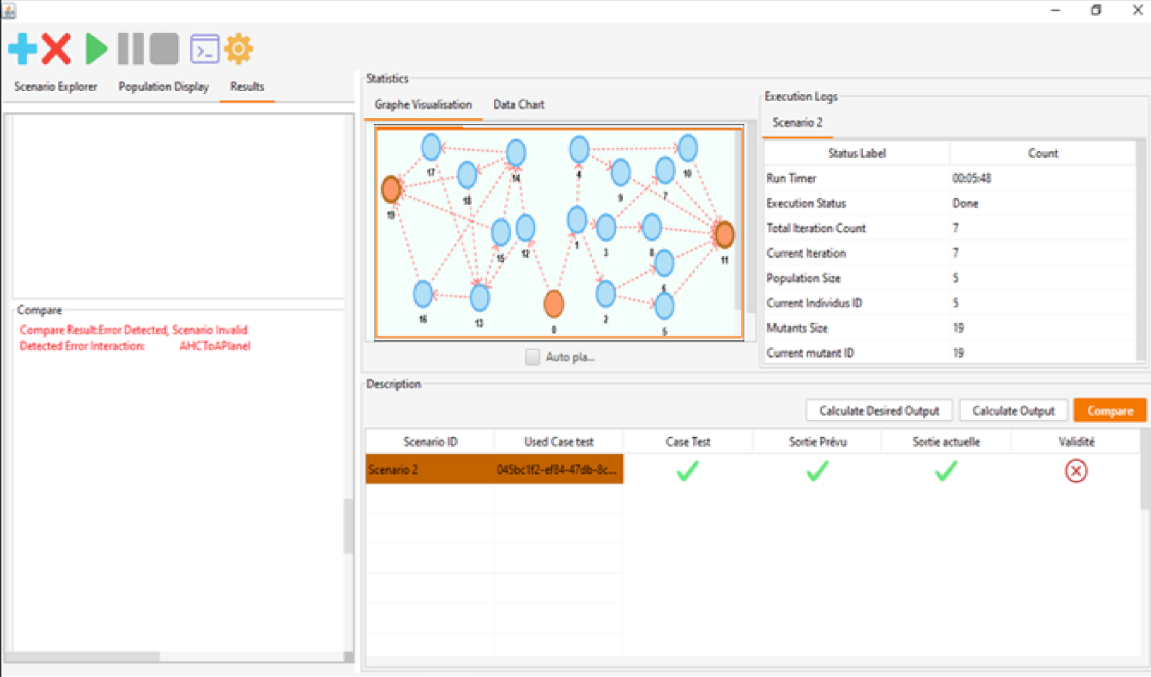
Figure 8. End of the test of scenario 2 (detection of an